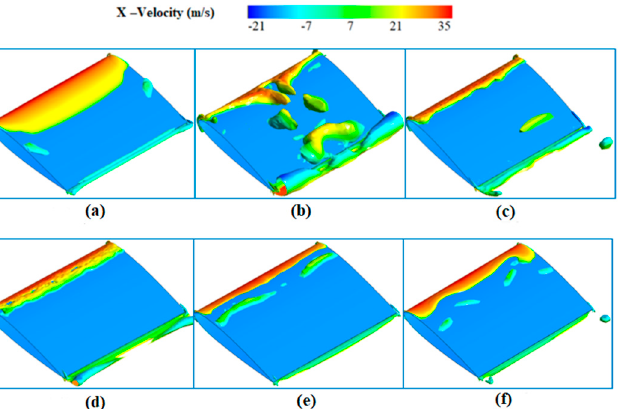
Figure 8. Iso-surfaces of vorticity (Q = 200000 s − 2 ) with velocity. ( a ) 14 ◦ ↑ ( b ) 18 ◦ ↑ ( c ) 20 ◦ ↑ ( d ) 17 ◦ ↓ ( e ) 15 ◦ ↓ ( f ) 13 ◦ ↓ .